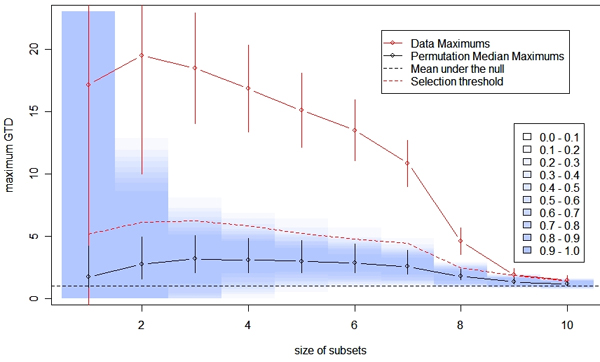
Evaluation of significance of in the RA candidategene study. For subsets of a given size, we plotted the highest GTD score (red solid line) with a 95% confidence interval (with Bonferroni correction for 220 - 1 multiple comparisons). The top GTD scores for sets of two to eight marker sets were significantly higher than the expected value under the null hypothesis (black dotted line at 1). Based on 100 permuted data sets, at different subset sizes, the black solid line displays the median maximum GTD scores and the vertical bars are the 95% confidence interval of permutations. For each permutation, we also calculated Bonferroni-corrected 95% confidence intervals for the maximum GTD scores. The blue shading indicates the coverage of these 100 confidence intervals at each subset size (the darkest being 0.9 to 1 (or 90 to 100%) and the lightest being 0.0 to 0.1 (or 0 to 10%)).